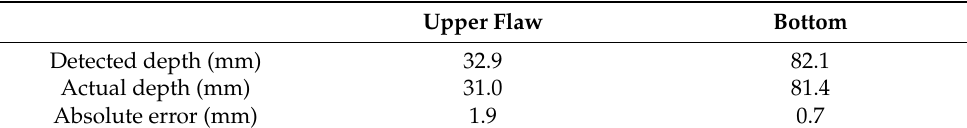
Table 3. Detection results of the proposed method for case 2.